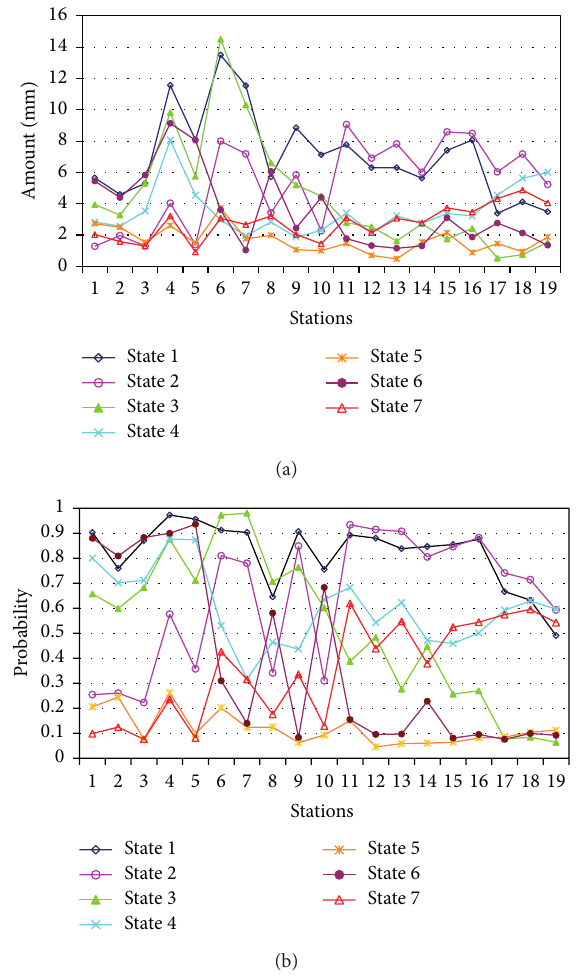
Figure 7: Distributions on stations of the NHMM seven states with the first 10 PCs of SLP as predictors: (a) rainfall amounts (mm); (b) correspondingprobabilitiesofrain.Positionofthestationsalongthe Danube basin is presented in Table